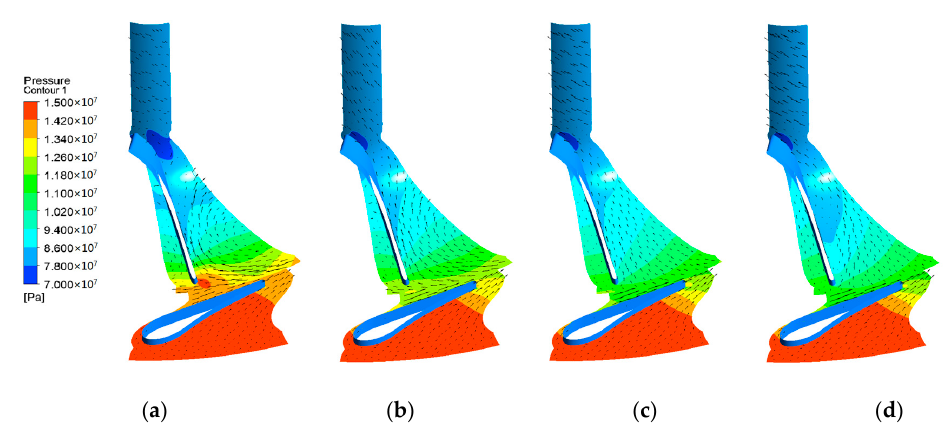
Figure 9. Pressure contours with vectors at the mid-span when LED = 10 mm: ( a ) T in = 400 K; ( b ) T in = 450 K; ( c ) T in = 550 K; ( d ) T in = 650 K.